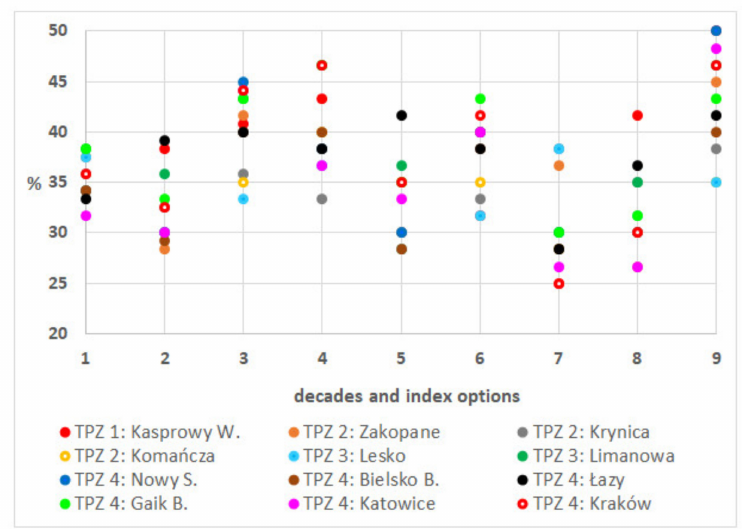
Figure 6. Percentage of dry months according to RPI (RPI ≤ 75%-for the whole year) and for the subperiods May-October and November-April in the decades of the study period. Stations are ordered following the concept of TPZ explained in Section 4.1. Explanation of numbers on axis